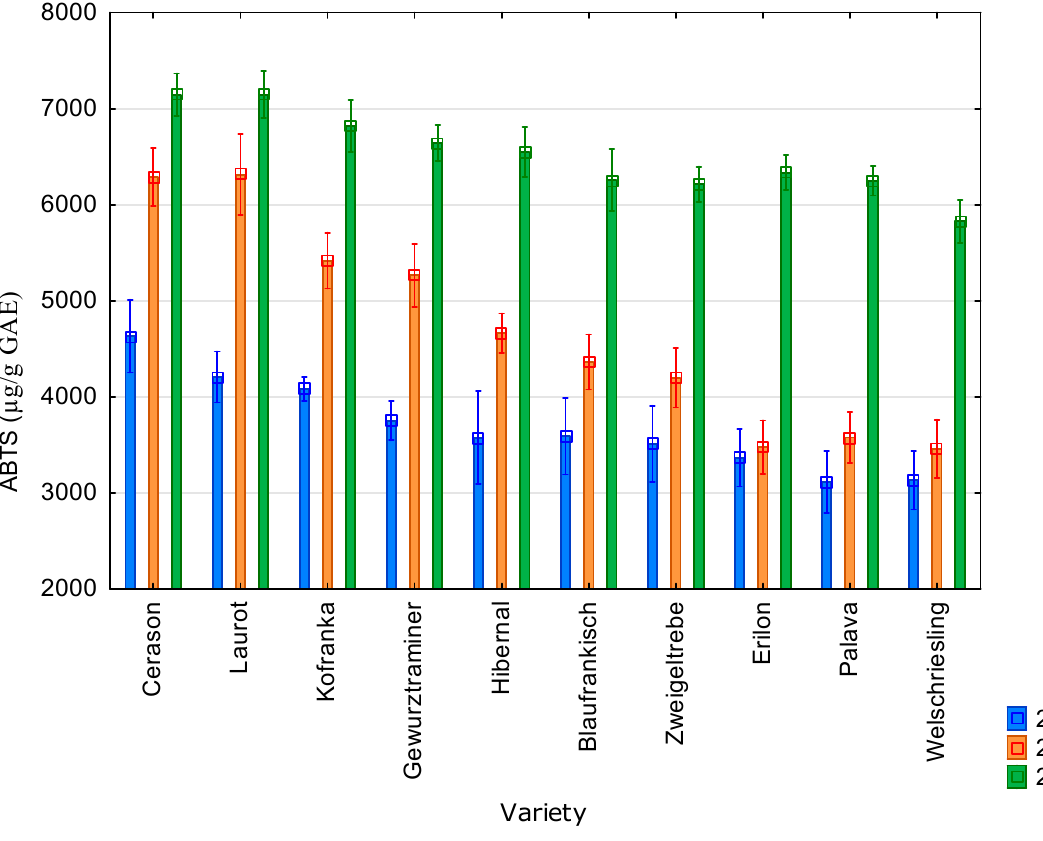
Figure 3. Values of antioxidant activity obtained using the ABTS method for individual vine varieties in 2015 (blue bars), 2016 (orange bars), and 2017 (green bars). 2015: p < 0.01, 2016: p < 0.01, 2017: p < 0.01.